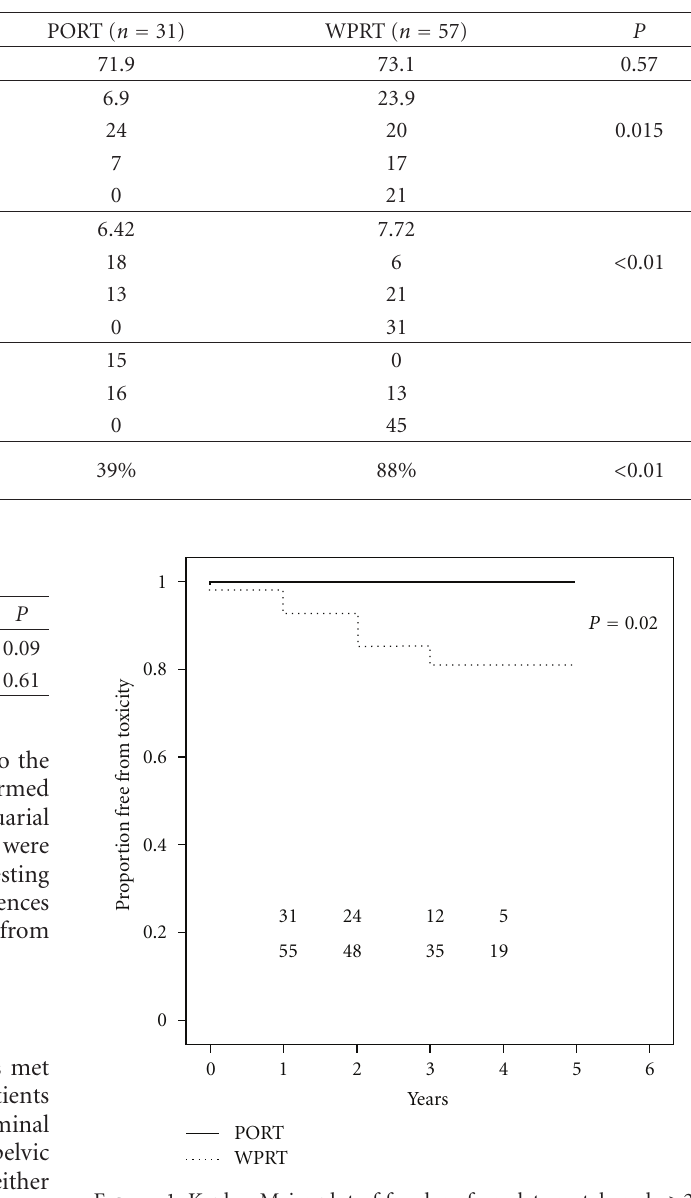
Figure 1: Kaplan-Meier plot of freedom from late rectal grade ≥ 2